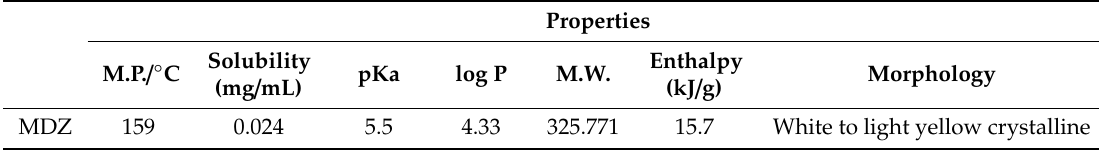
Table 1. The attributes of